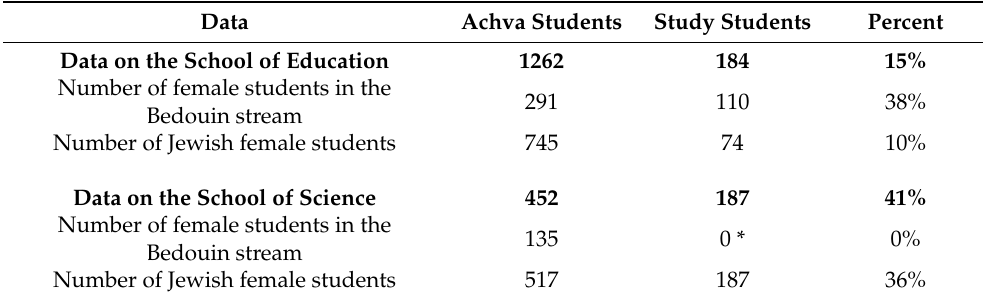
Table 1. The number of female students participating in the study out of the number of female students at the college, according to school and ethnic origin, in